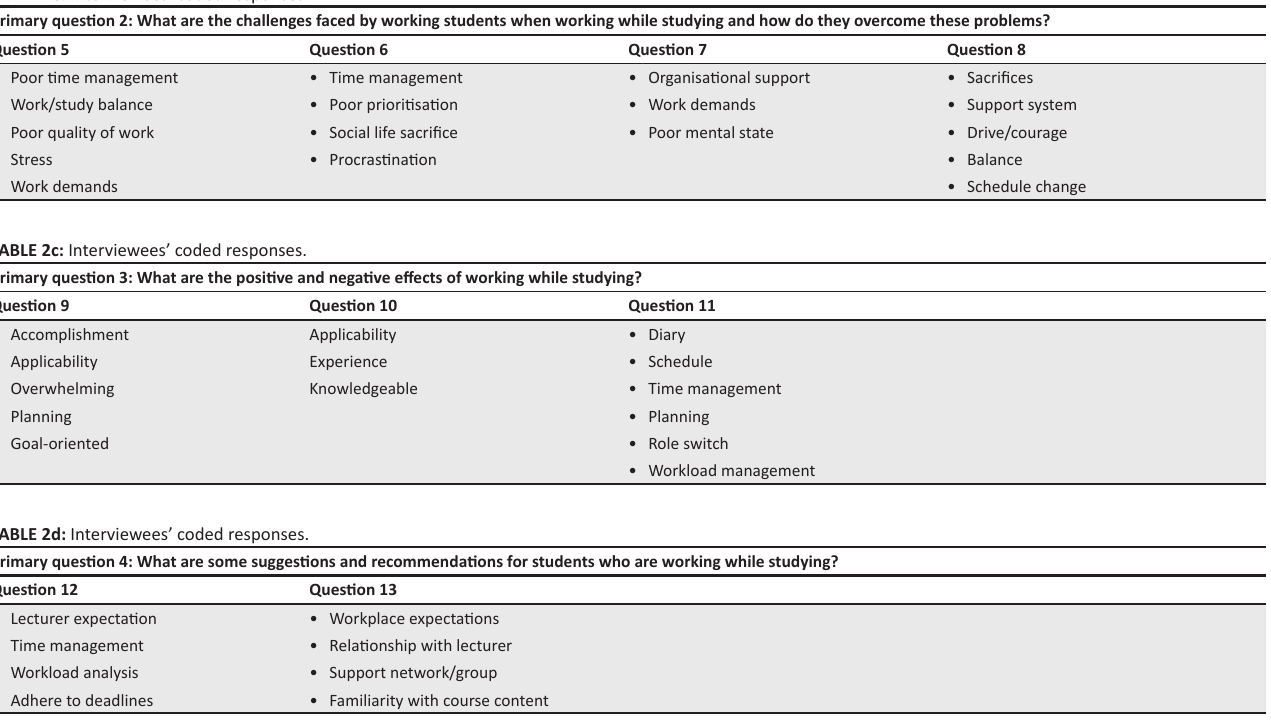
TABLE 2b: Interviewees’ coded responses.